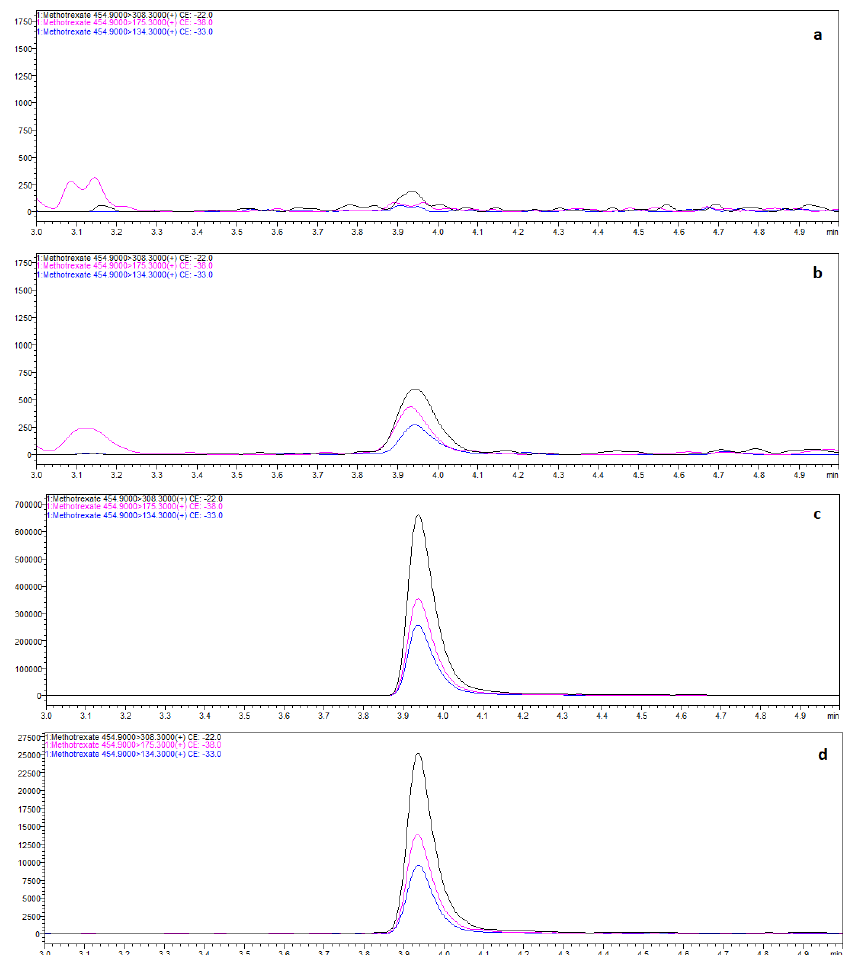
Figure 2. MRM of methotrexate in blank human postmortem blood ( a ), 0.1 ng/mL—low QC ( b ), 100 ng/mL—medium QC ( c ) and real sample of human blood with methotrexate at concentration of 7.2 ng/mL—case 3 ( d ).